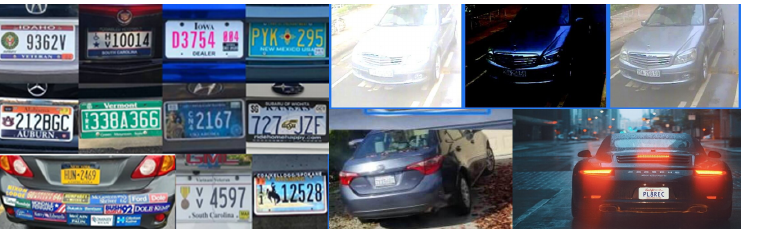
Figure 3. License plate diversity in styles, colors, fonts, sizes, and physical conditions. (Source: Plate Recognizer ALPR [14]-a division of ParkPow